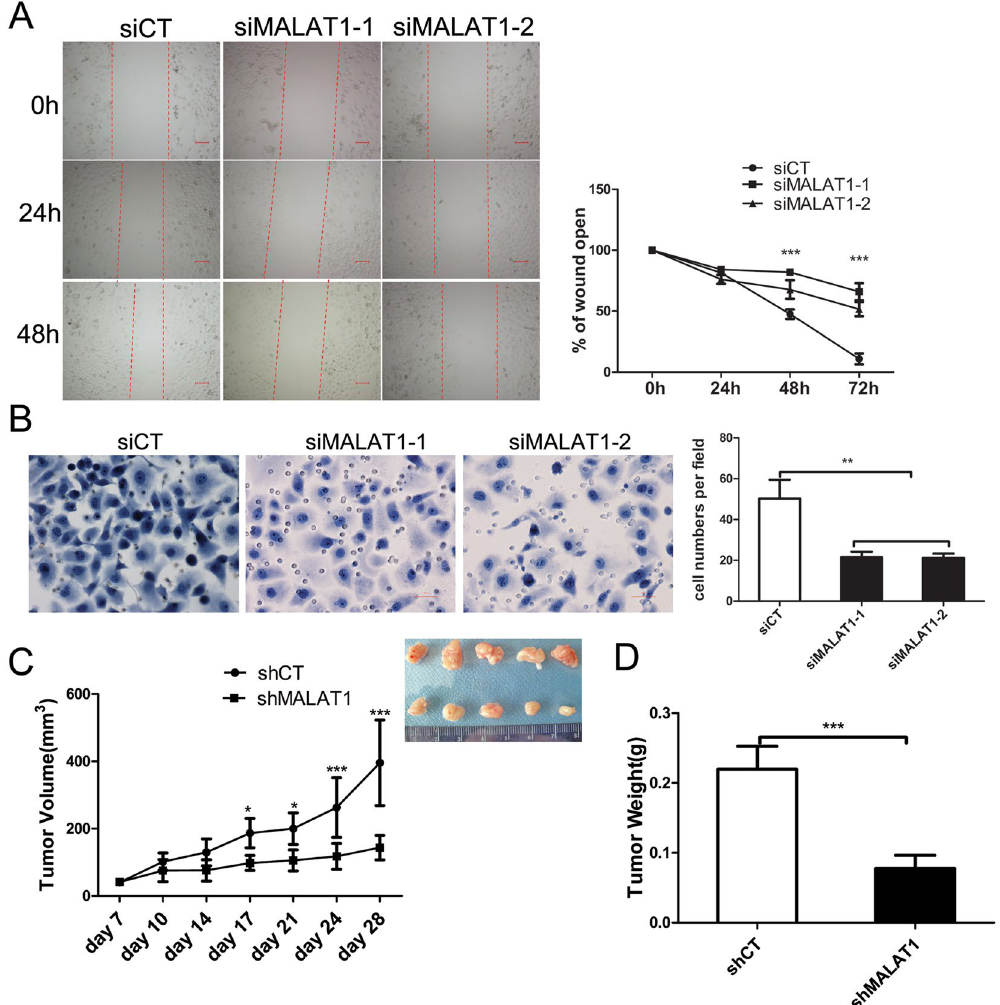
Figure 4. MALAT1 knockdown inhibits tumour cell migration, invasion and growth in vivo . ( A ) Closure of wounds made in a confluent monolayer of Panc-1 cells transfected with siRNAs. For each experimental group, the percentage of the wound remaining open, which was determined based on the size of the wound at 0 hours, is shown. ( B ) The effects of MALAT1 knockdown on cell invasion, as determined by the transwell invasion assay. ( C ) Panc-1 cells transfected with shCT vector or shMALAT1 vector were subcutaneously injected into the posterior flanks of nude mice. Tumour volumes were measured at regular intervals. Finally, the tumours were photographed and weighed ( D ). All the quantitative results in this study are presented as the mean ± standard error of the mean of at least three replicate determinations of each data point. * p < 0.05, ** p < 0.01, *** p < 0.001 for siMALAT1 vs